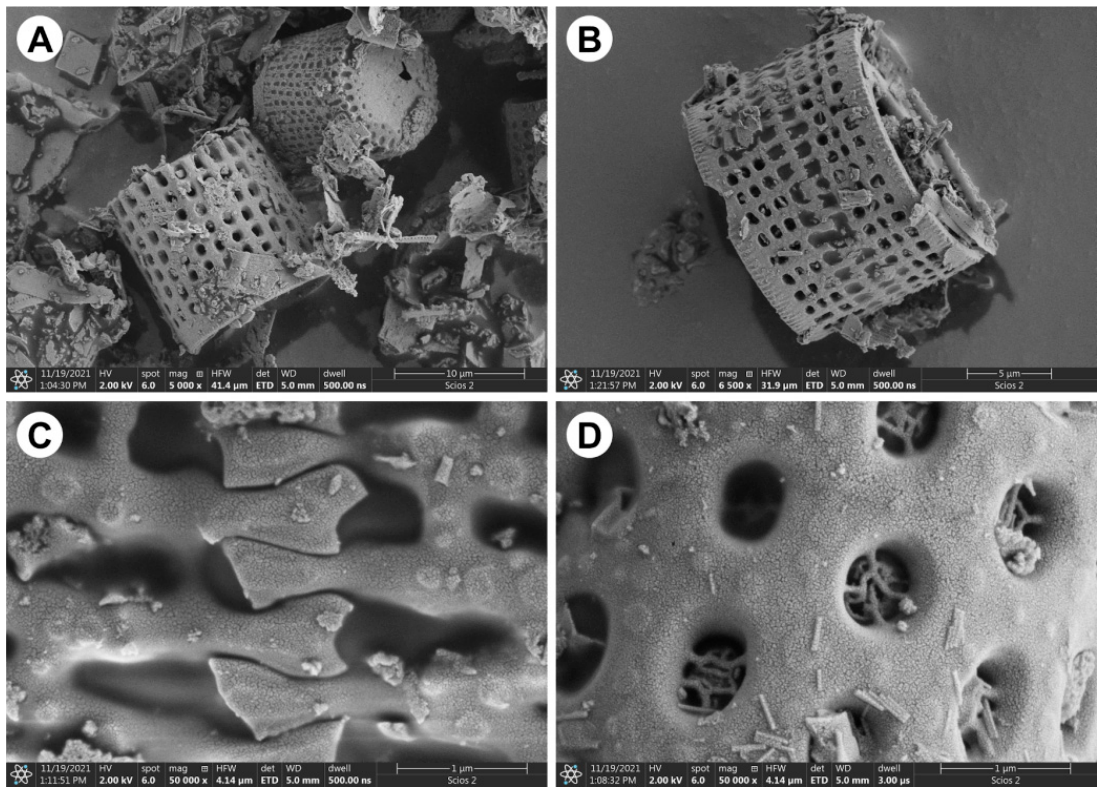
Figure 1. SEM images of the reinforcement—diatomaceous earth: ( A , B ) frustules of Aulacoseira sp., ( C ) magnification of the zip between frustules, ( D ) magnification of the openings and structures inside the openings.